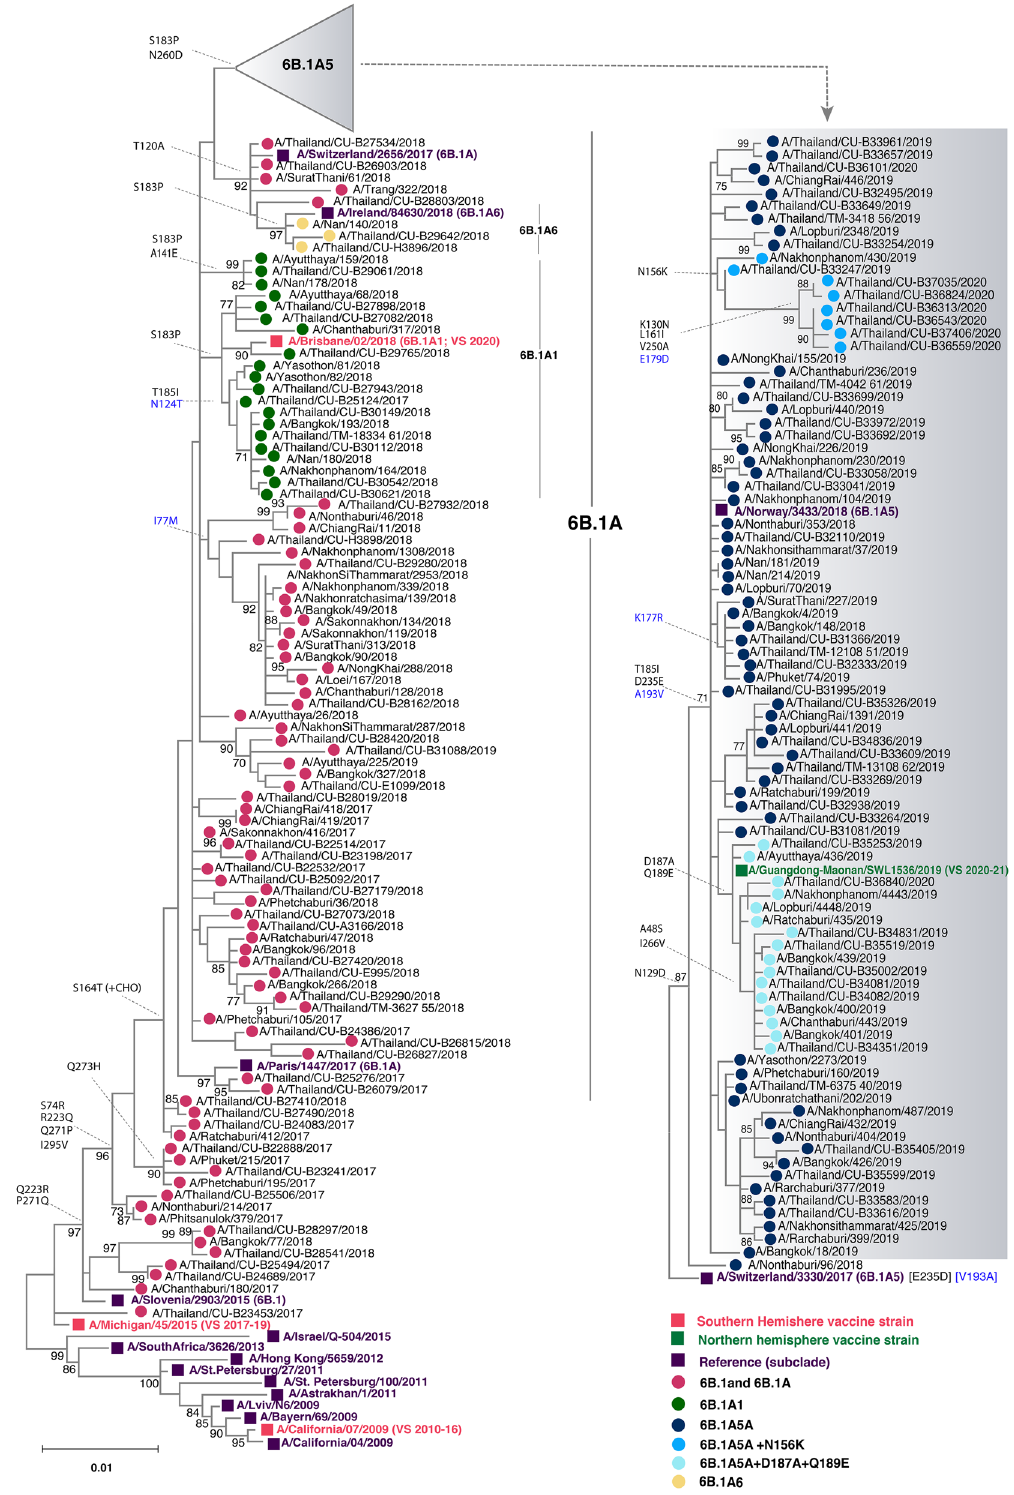
Figure 2. Phylogenetic analysis of the entire HA gene of A(H1N1)pdm09. Sequences from 90 A/Thailand/CU strains and 93 other Thai strains available from the database were compared with the A(H1N1)pdm09 vaccine and reference strains of known clades. Phylogenetic tree was constructed using the maximum-likelihood method using the TN93 + G model with 1,000 bootstrap replicates implemented in MEGAX. Branch values of > 70% are indicated at the nodes, along with the characteristic residues defining these branches. Residue changes in HA1 are denoted in black; changes in HA2 are in blue. Gain (+ CHO) and loss (−CHO) potential glycosylation sites were indicated. Southern hemisphere vaccine strains (magenta squares), the 2020–21 northern hemisphere vaccine (green squares) and the reference strains (purple squares) are indicated. Colored circles indicate the clade and subclade of A(H1N1)pdm09 circulating strains. VS defined as vaccine